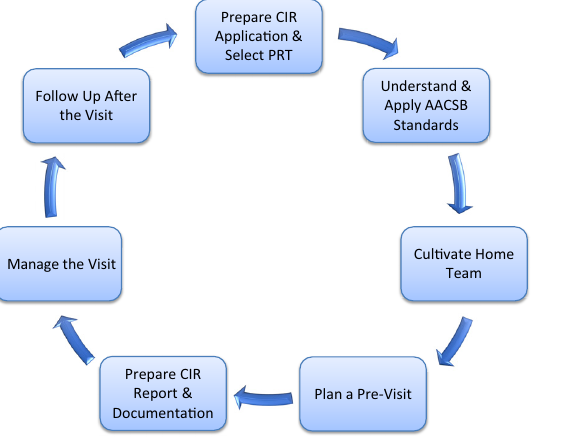
Figure 1. Best practices for